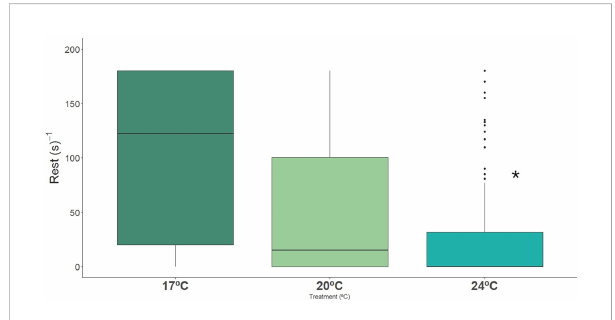
FIGURE 2 Time spent in stationary behavior (s -1 ) by long-snouted seahorse exposed to different temperature treatments (17°C, 20°C and 24°C). Bold * represent signi fi cant differences from control treatment.